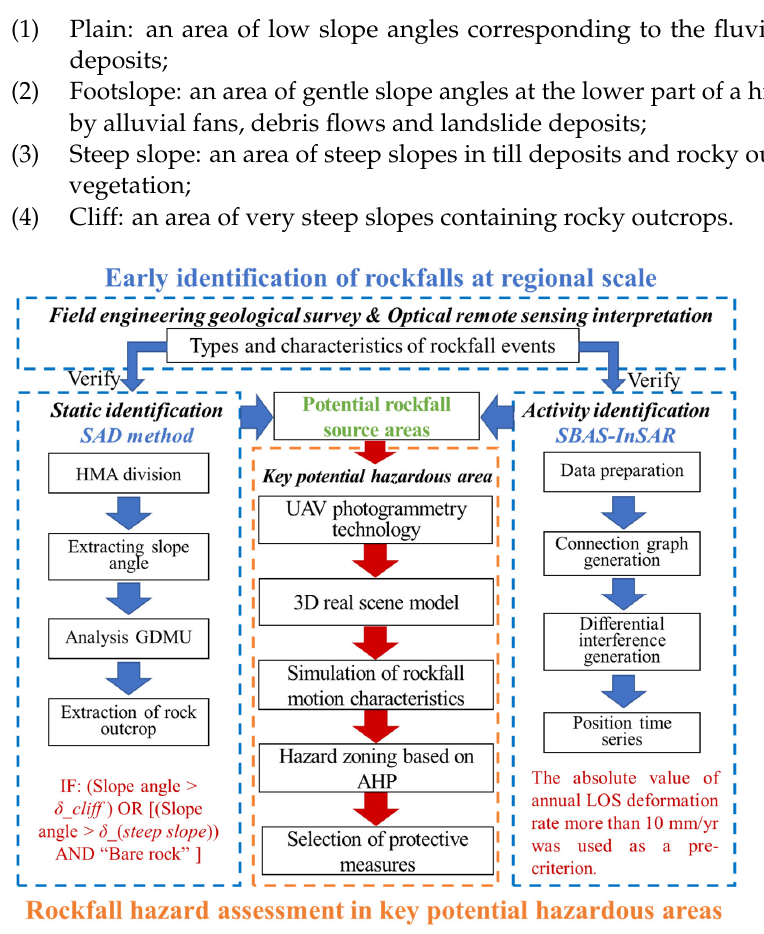
Figure 7. A technical framework for rockfall hazard assessment incorporating regional-scale identification of potential rockfall source areas.